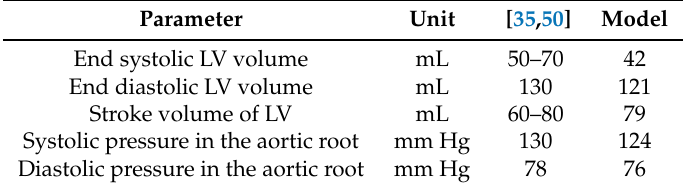
Table 5. Validation of the integrated model for the heart and the aorta in healthy conditions without LVAD.